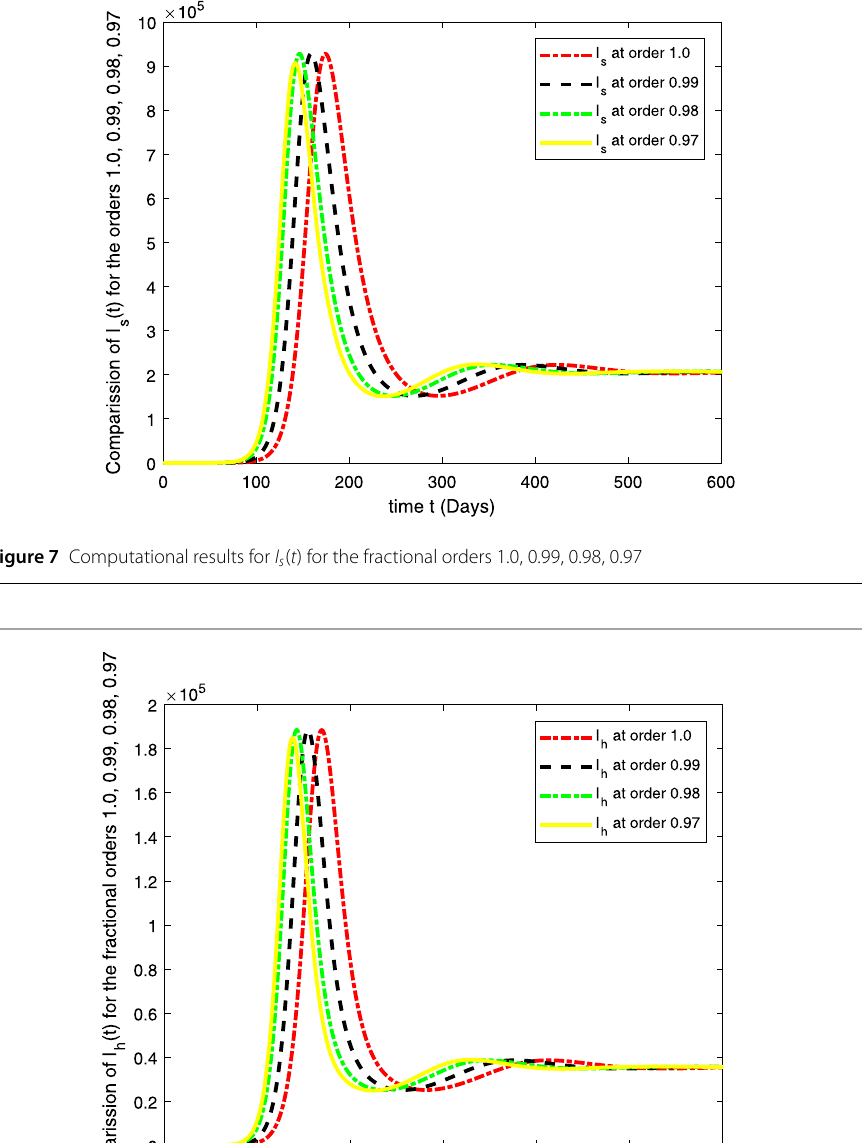
on the literature. The initial values for the population are: S (0) = 6,778,382, E (0) = 1, I s (0) = 0, I h (0) = 0, A (0) = 0, R (0) = 0, and the parametric values are: b 1 = 57,554, b 2 = 1/85, N = 6,778,383, β = 1/ N , β a r = 1, β h r = 1/80, γ = 1/5.5, η = 0, α = 0.12, τ 0 = 1/10, p s = 0.55, p h = 0.20, k v = 0.001, k T = 0.004 [37]. The results are more realistic and of the same behav- ior as the classical ones. Our results are getting more similar to the integer order ones for the orders closer to